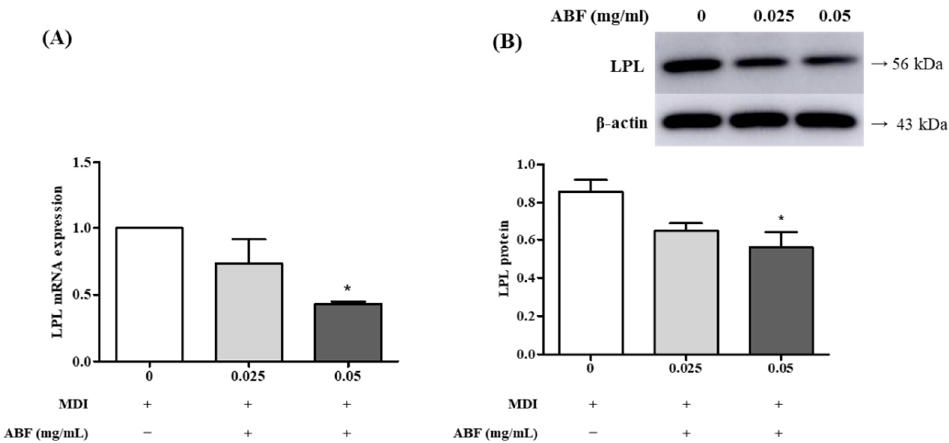
Figure 6. Effects of lipoprotein lipase (LPL) on the Aronia bioactive fraction (ABF ® ) in 3T3-L1 adipocytes. 3T3-1 adipocytes were treated with ABF ® (0.025 and 0.05 mg/mL). ( A ) RT-qPCR measured mRNA expression of LPL. ABF ® (0.05 mg/mL) significantly reduced LPL mRNA in 3T3-L1 adipocytes. ( B ) Protein expression of LPL was measured by Western blot. ABF ® (0.05 mg/mL) significantly reduced LPL protein in 3T3-L1 adipocytes. Data represent the mean ± SEM. * p < 0.05 compared with the MDI control group.